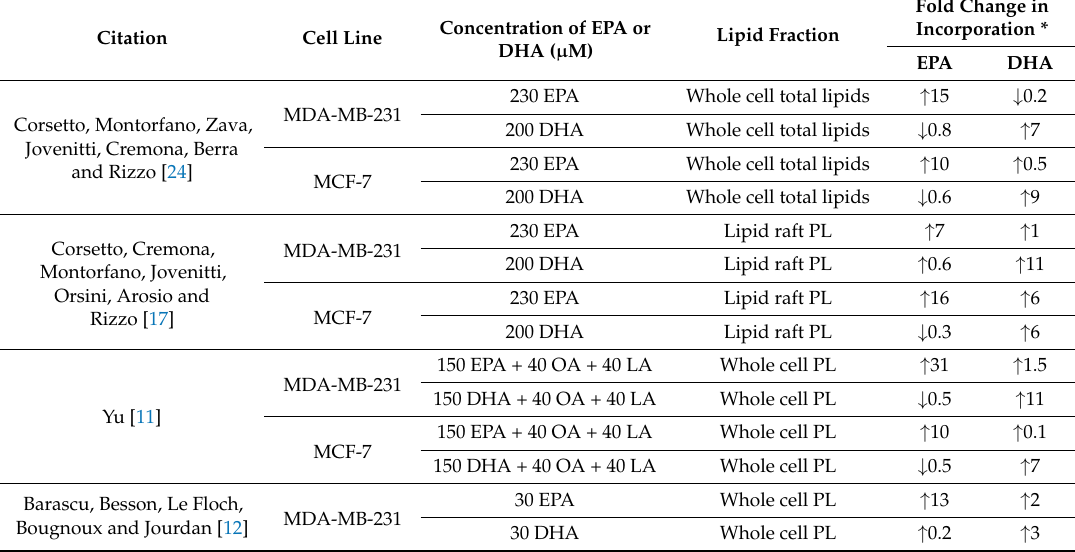
Table 3. Incorporation of EPA and DHA measured in the plasma membrane when comparing EPA to DHA in human BC cell